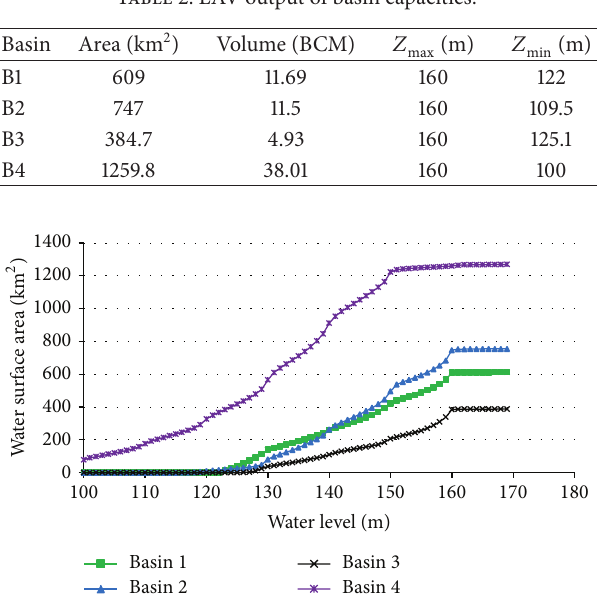
Figure 4: Topographic relation of water surface area versus water level.